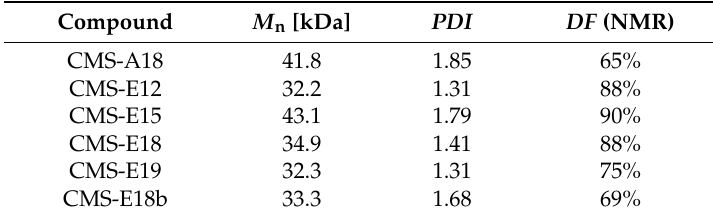
Table 1. Estimation of the degree of functionalization (NMR) and GPC analytical data.